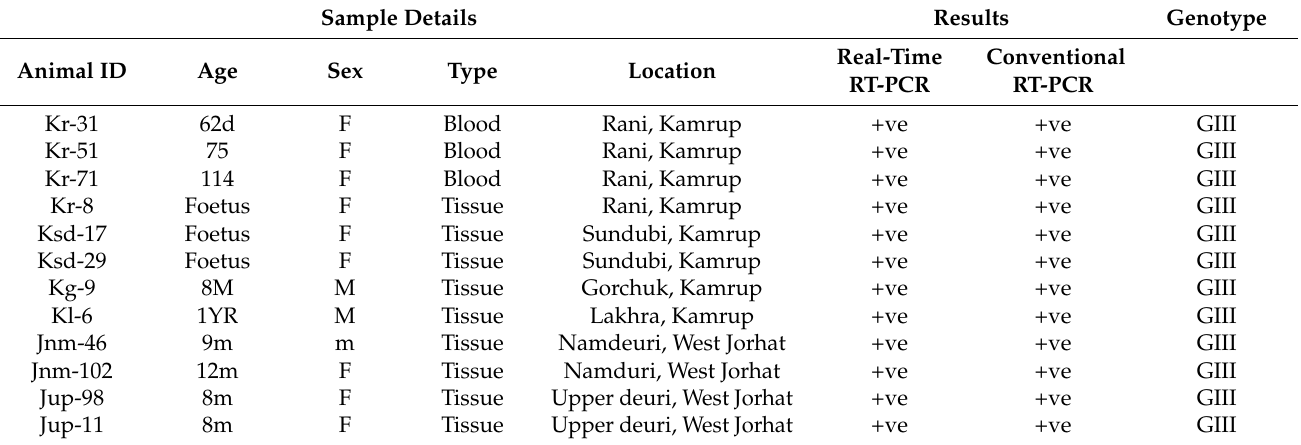
Table 1. Description of JEV positive samples collected from pigs from Jorhat and Kamrup District.